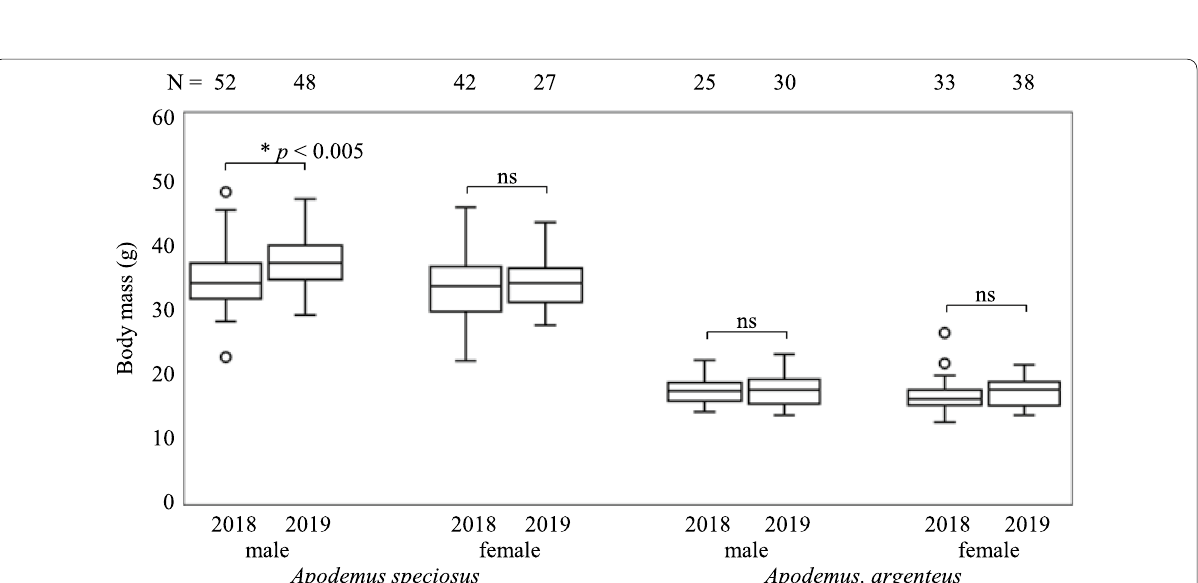
Fig. 3 Boxplots of adult body mass of two Apodemus species individuals captured in 2018 and 2019. The numbers on the top are sample size ( n ). (Student’s T test: male A. Speciosus ; T 3.01, p < 0.005, female A. speciosus ; T = − argenteus ; T 0.68, p > = −